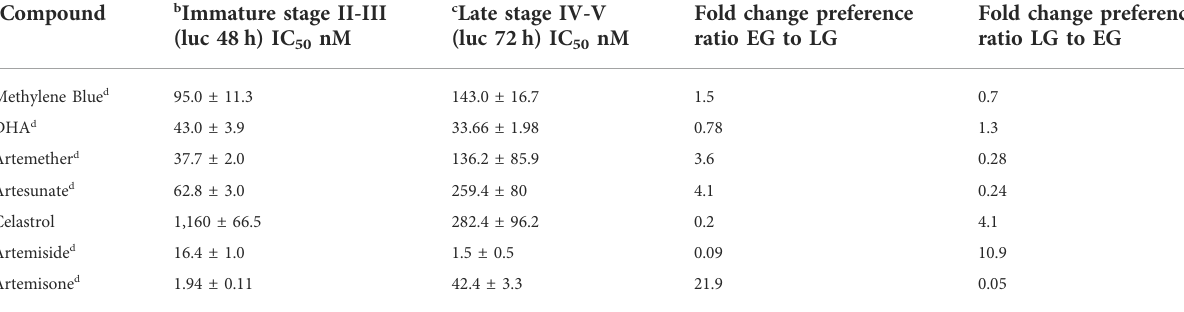
TABLE 2 Activities (nM) in vitro against immature stage II-III and late stage IV-V P. falciparum NF54